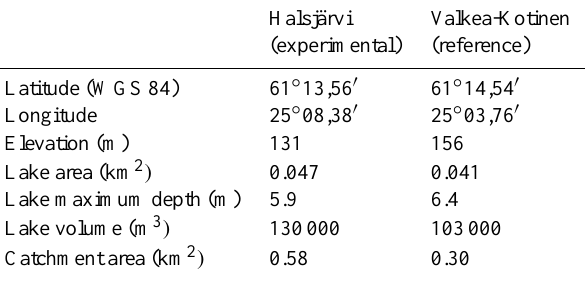
Table 1. Morphologic and hydrographic characteristics of lakes Halsj¨arvi (experimental lake) and Valkea-Kotinen (reference